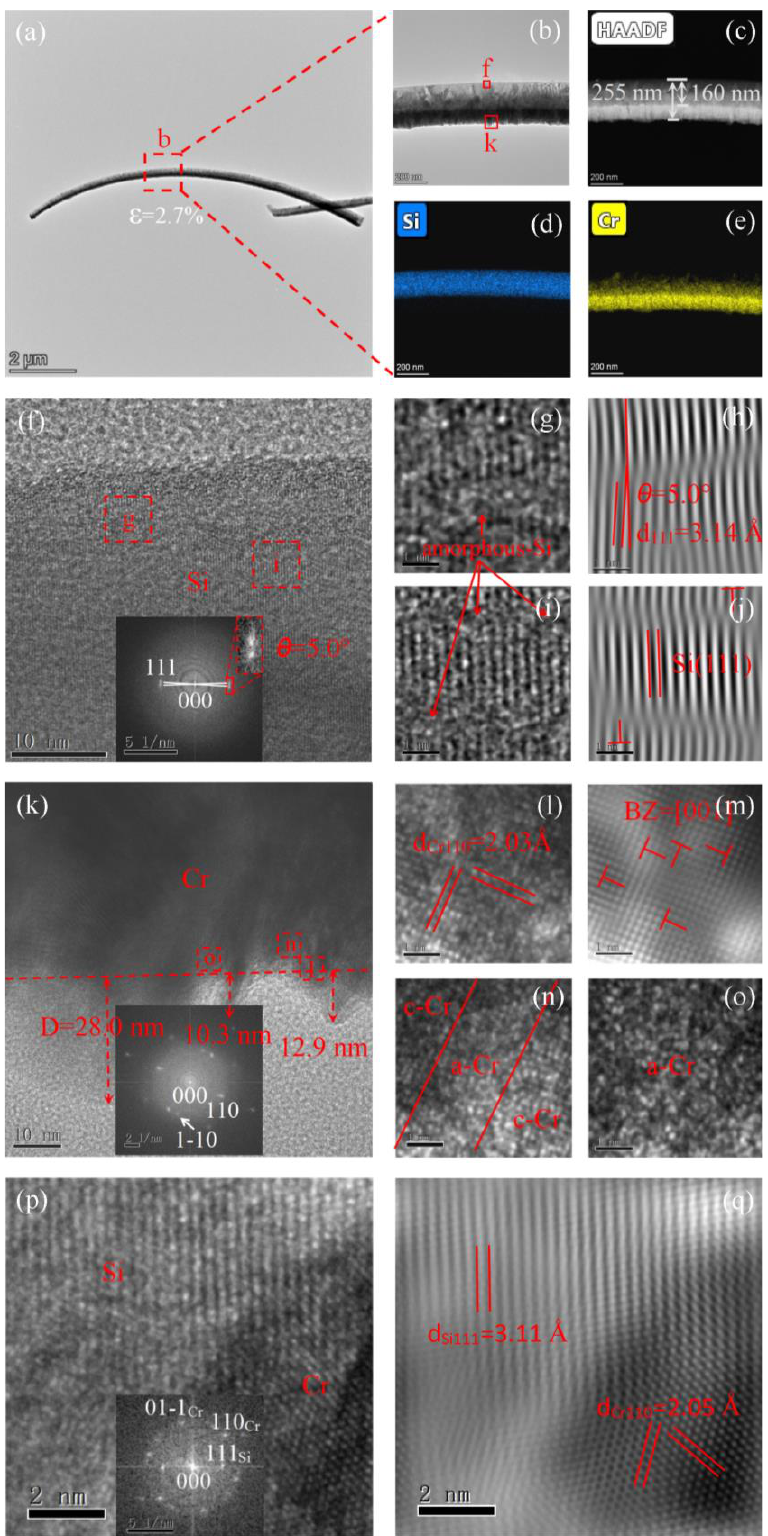
Figure 2. Bright-field TEM ( a , b ), HAADF ( c ), and STEM-EDX elemental mapping ( d , e ) images of Si NWs with 2.7% bending strain. HRTEM image of Si ( f – j ), asymmetric Cr ( k – o ), and Si/Cr interface ( p , q ). Panels h, j, m, and q show Fourier-filtered images. The insets of panels f, k, and p display FFT patterns of Si, asymmetric Cr, and Si/Cr interface, respectively.